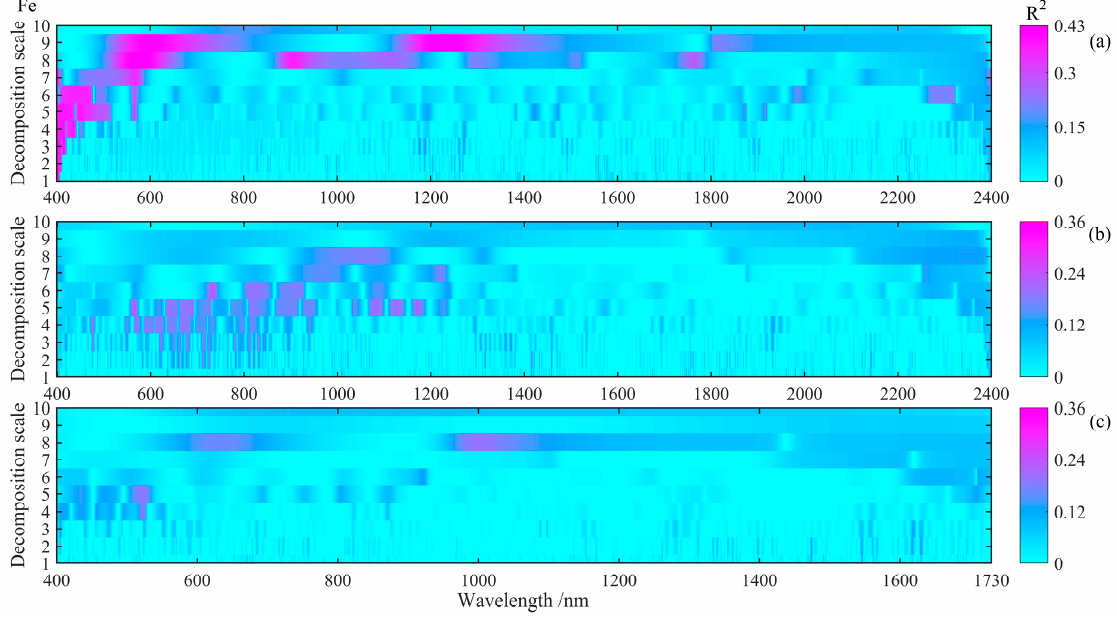
Figure 7. R 2 between Fe content and spectral reflectance transformed by CWT using ten decomposition scales under three experimental conditions. ( a ): LPS, ( b ): LUS, ( c ): FS.